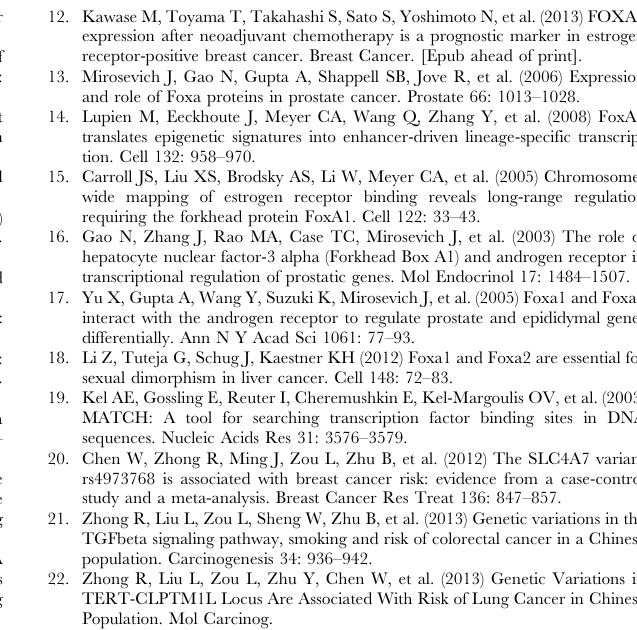
Table S1 Candidate variants identified by bioinformatic proce- dure.